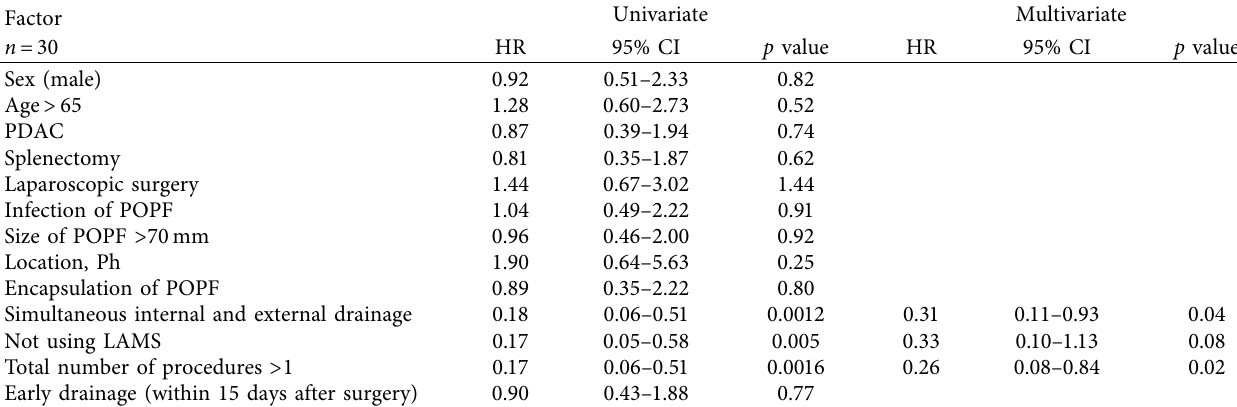
Table 3: Univariate and multivariate analyses of factors influencing prolonged hospitalization after EUS-TD.